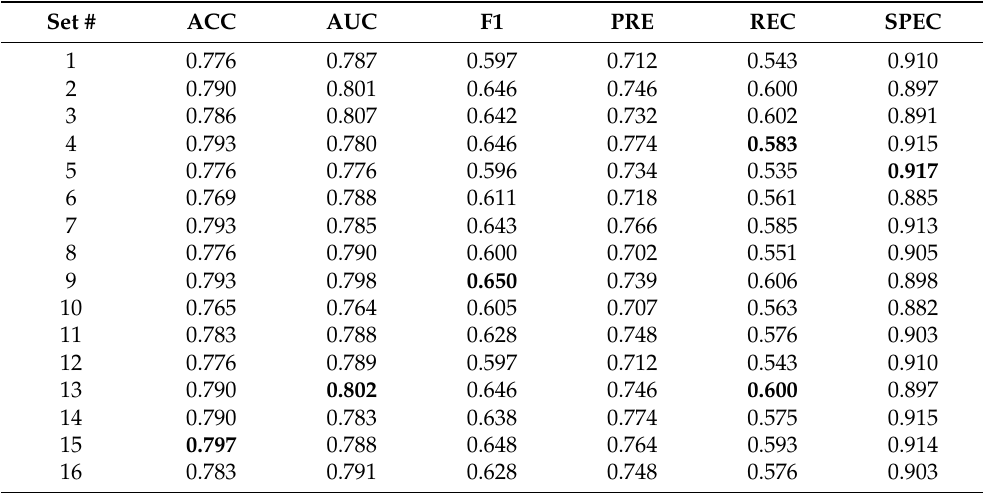
Table 4. Computational results for the CGGA dataset with the voting-based feature selection process.